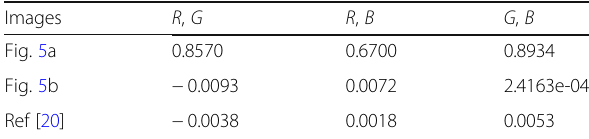
Table 5 Adjacent position with R , G , B